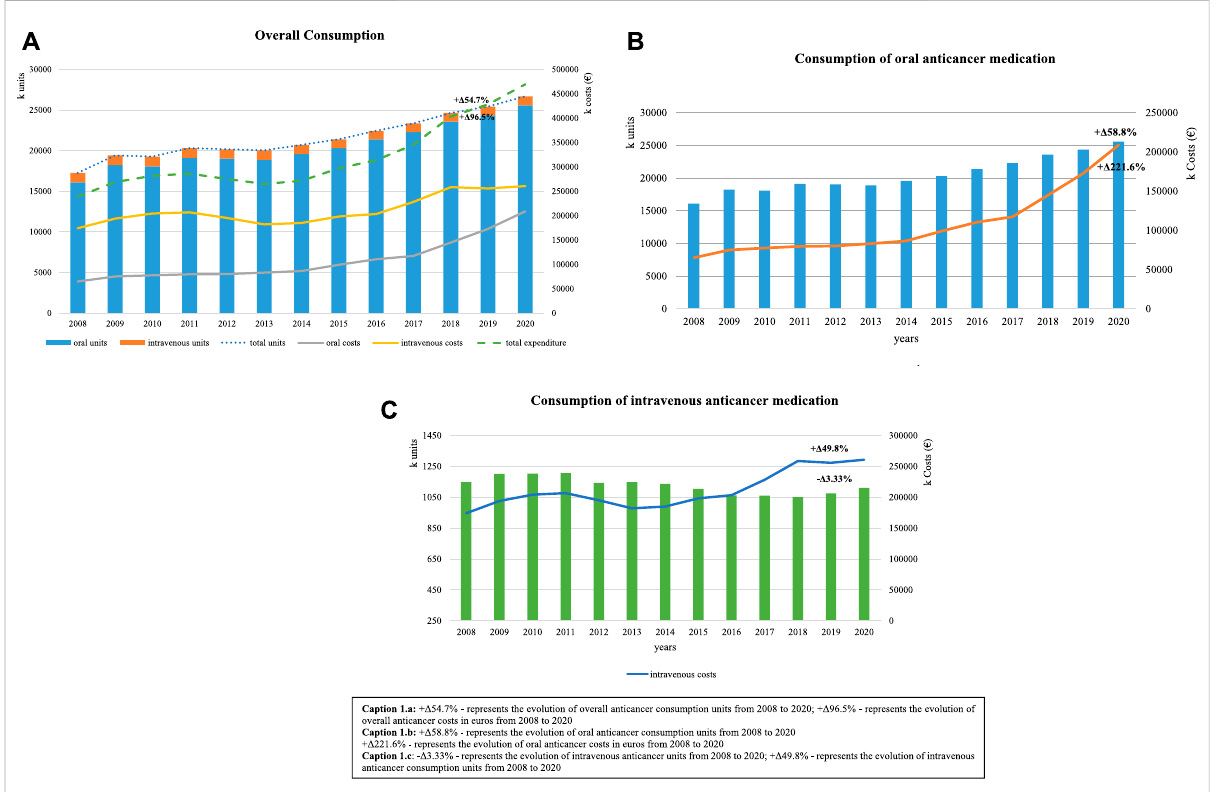
FIGURE 1 Consumption trends of anticancer medication over a 13-year period, measured in units with respective costs. (A) + Δ 54.7% represents the evolutionofoverallanticancerconsumptionunitsfrom2008to2020and+ Δ 96.5%representstheevolutionofoverallanticancercostsineurosfrom 2008 to 2020. (B) + Δ 58.8% represents the evolution of oral anticancer consumption units from 2008 to 2020 and + Δ 221.6% represents the evolution of oral anticancer costs in euros from 2008 to 2020. (C) − Δ 3.33% represents the evolution of intravenous anticancer units from 2008 to 2020 and + Δ 49.8% represents the evolution of intravenous anticancer consumption units from 2008 to 2020.